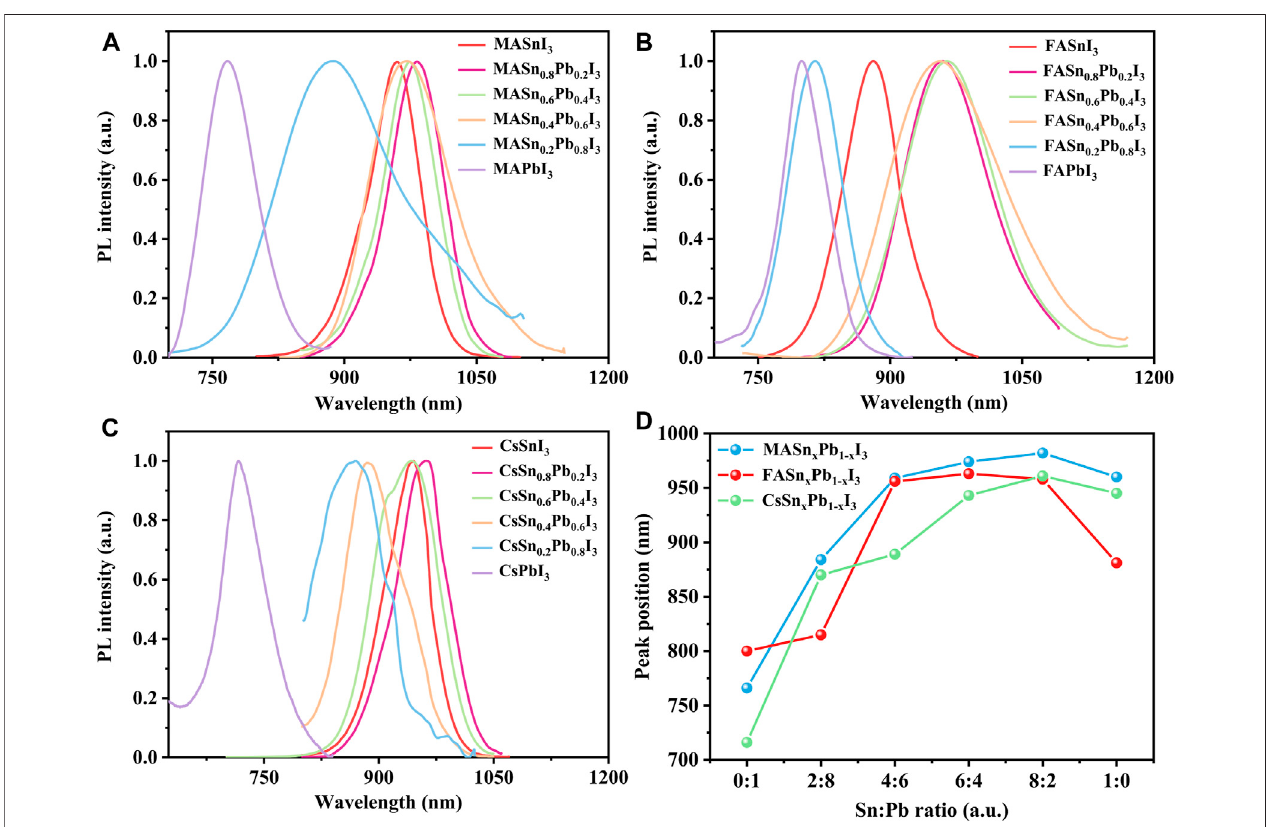
FIGURE 4 | Normalised PL spectra of (A) MASn x Pb 1-x I 3 , (B) FASn x Pb 1-x I 3 and (C) CsSn x Pb 1-x I 3 ; (D) PL peak position of each composition.